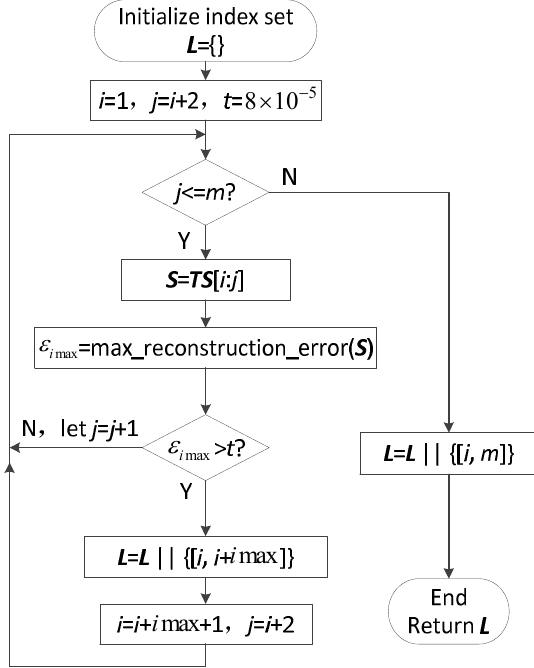
Figure 5. Flow diagram of straight-line segmentation.